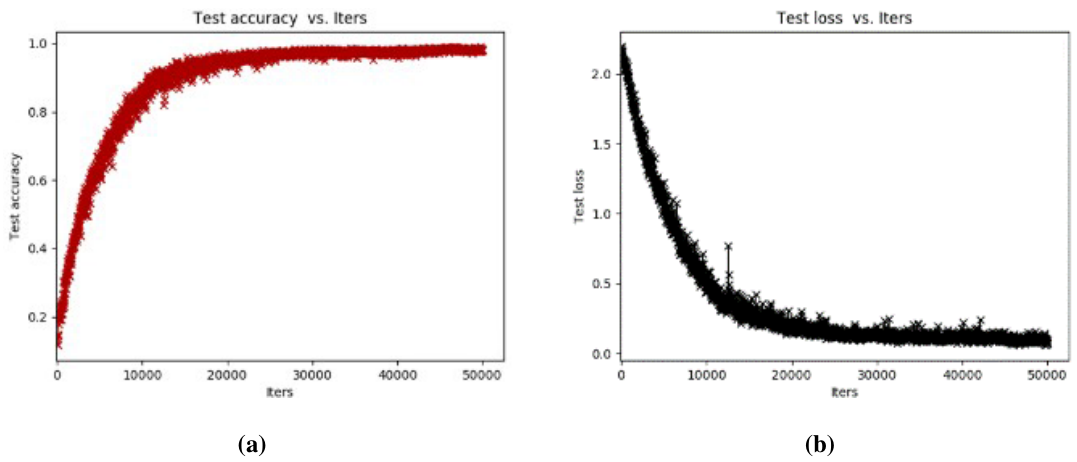
Fig. 10 Experimental results of the original AlexNet model. (a) The relationship between test accuracy and the number of iterations and (b) The relationship between model loss and